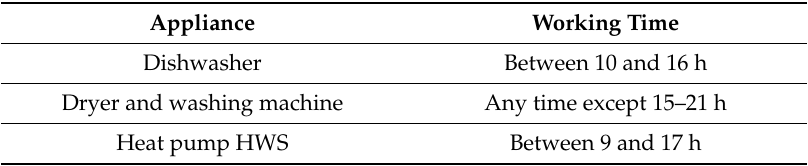
Table 5. Manageable / shiftable